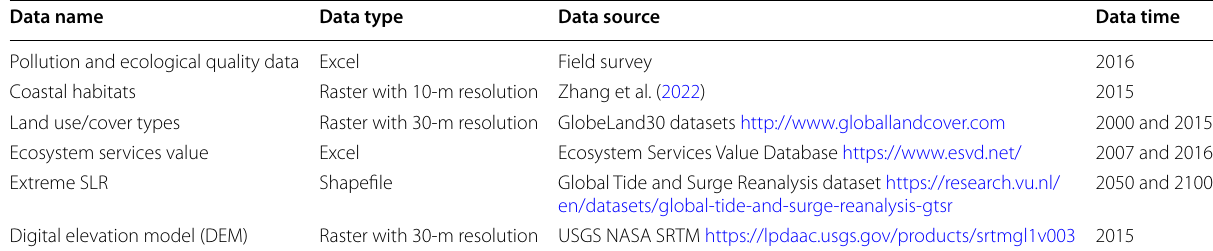
Table 1 Data sources and characteristics used in this